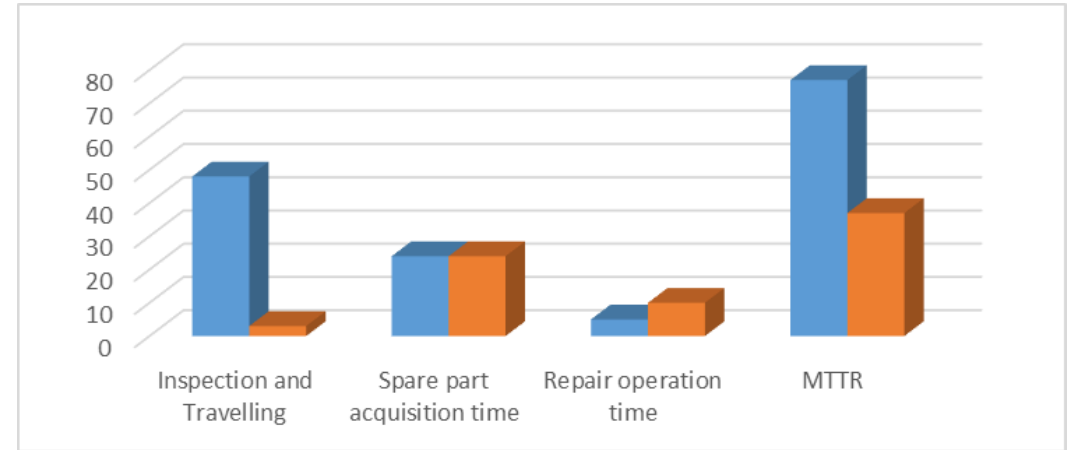
Figure 10. Time per maintenance action AS-IS situation vs. Proposed Methodology.